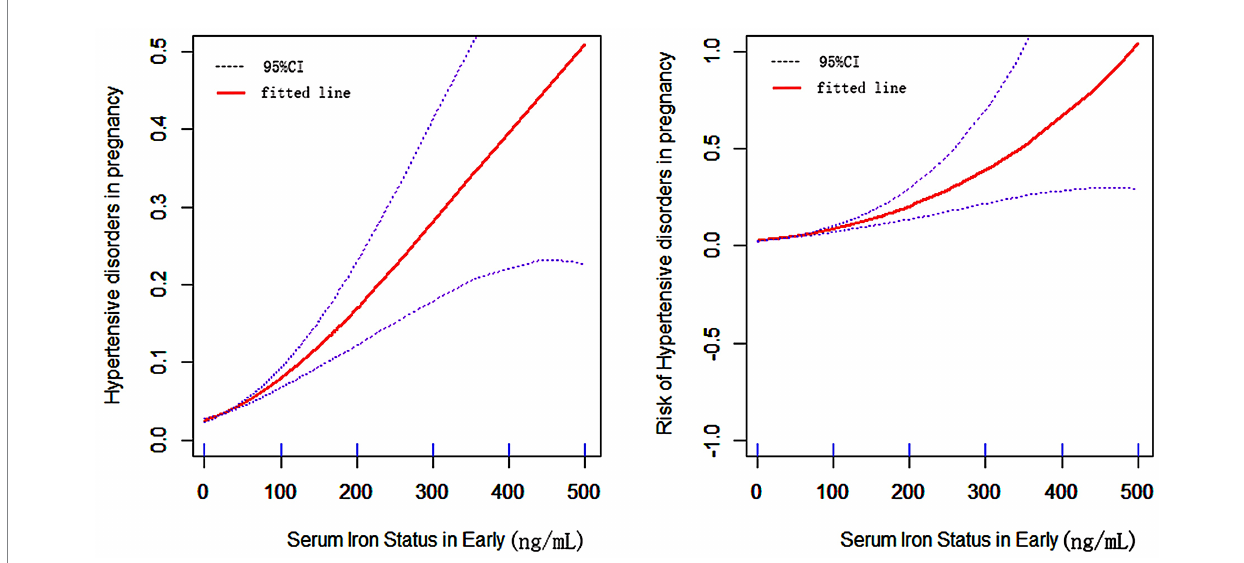
FIGURE 4 The relationship between SF in early pregnancy and hypertensive disorder in pregnancy. (Horizontal coordinates of both graphs are SF in early pregnancy, vertical coordinates of the left graph are the probability of developing HDP, vertical coordinates of the right graph are the risk of developing HDP, the solid line in the middle is the fitted line and the dashed lines on either side are 95% confidence intervals).